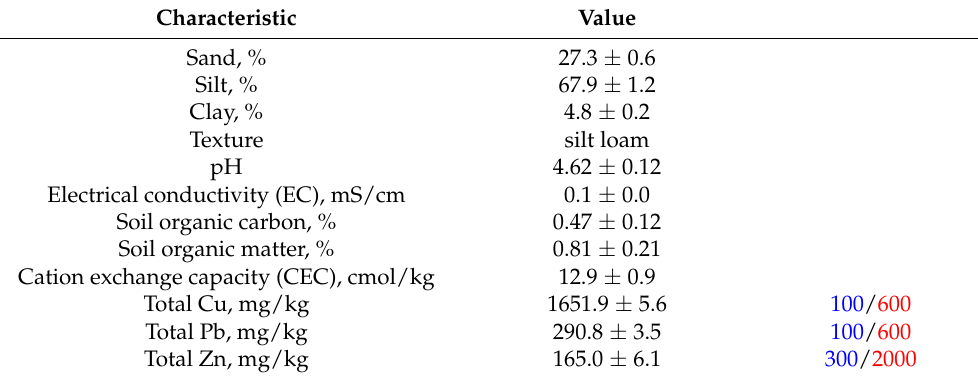
Table 1. Selected physicochemical characteristics of smelter contaminated soil (mean ± SD, n = 3).